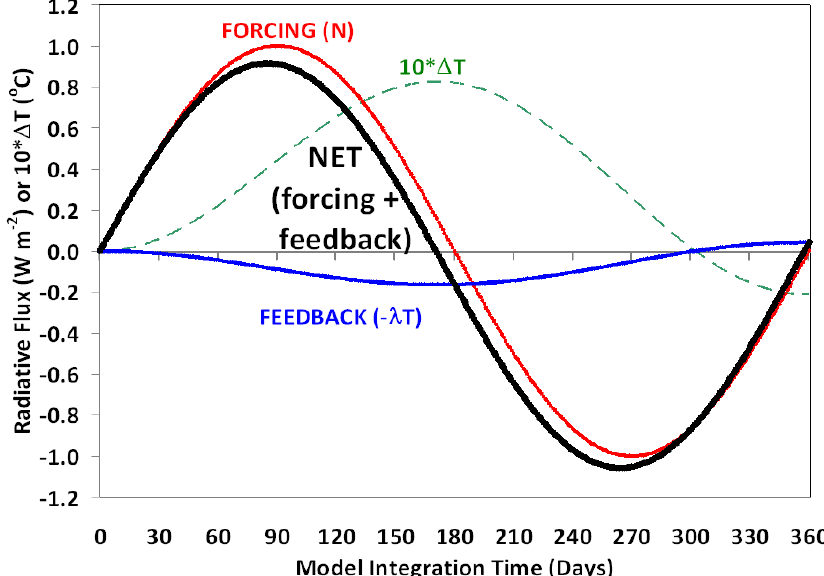
Figure 1. Simple forcing-feedback model demonstration that satellite radiative budget instrument measurements of Net radiative flux (forcing + feedback) are very different from what is needed to diagnose the net feedback parameter (feedback